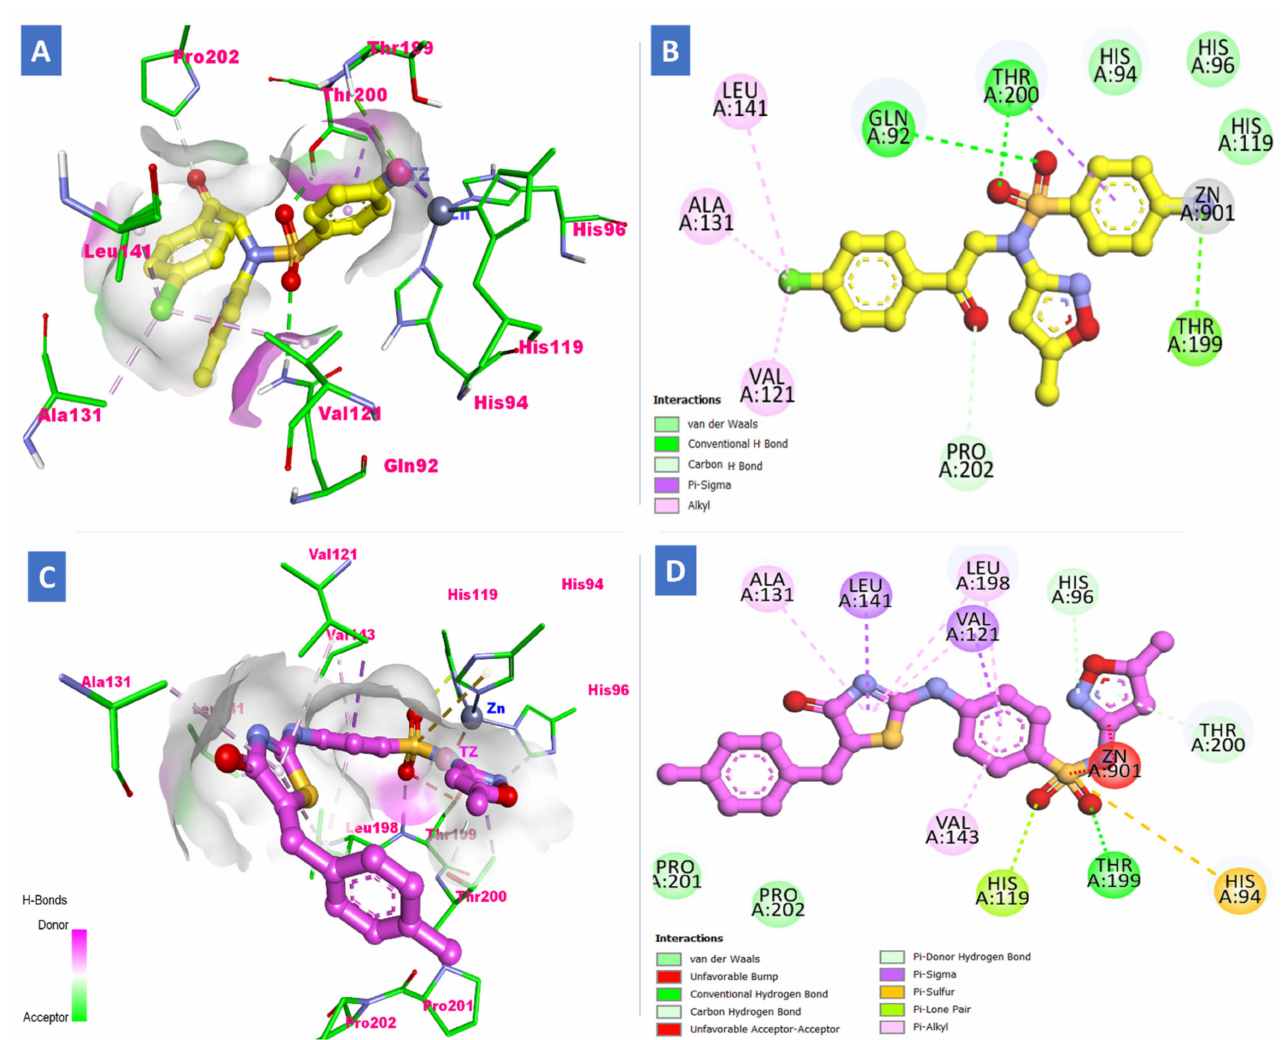
Figure 10. The docking results and interactions of compounds S15 (yellow) and S19 (violet) into the active place of hCA-XII isoenzyme (PDB code: 1JD0); ( A , B ) 3D and 2D binding modalities of S15 , respectively; ( C , D ) 3D and 2D binding modalities of S19 , respectively. The docked poses were displayed in ball & stick style. Zn atom was shown as a blue ball while pseudoatom TZ was represented as a pink ball. Unfavorable co-ordinate bond with Zn cation or clashes were displayed in dashed red lines. π -Sulfur and hydrophobic interactions were represented as orange and light violet dashed lines, respectively. Hydrogen bond surfaces around docked poses were created. Hydrogen atoms were omitted for clarity